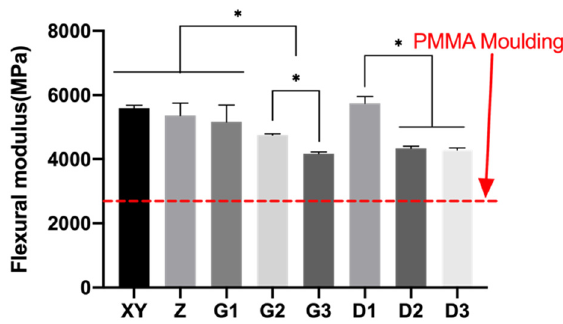
Figure 14. Mean and standard deviations of flexural modulus of 3D-printed PEEK. * p < 0.05.